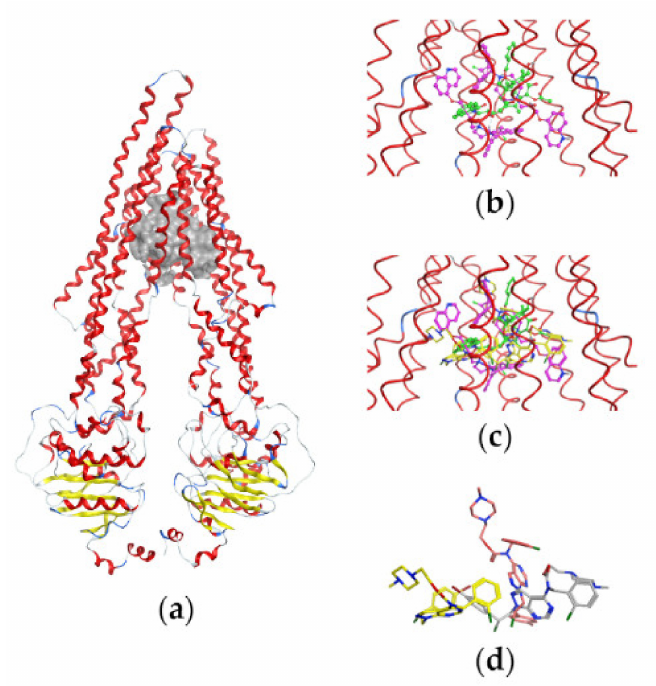
Figure 6. Binding of pro-Si221 in the P-gp cavity. ( a ) A front view of the P-gp structure used in docking studies with the bound substrate PTX (in green) and two molecules of the inhibitor Zosuquidar (in magenta); the protein backbone is shown as a ribbon and is colored according to the secondary structure—loop (in grey), helix (in red), and turn (in blue). ( b ) A closer view of the transmembrane-binding cavity of P-gp with bound PTX and two molecules of Zosuquidar (shown as balls and sticks). ( c ) A closer view of the transmembrane-binding cavity of P-gp with bound PTX, Zosuquidar, and three conformations of pro-Si221 (yellow sticks) corresponding to three different binding poses among the 10 best generated during docking. ( d ) The three different poses of pro-Si221 (shown as yellow, orange, and light gray sticks) positioned equally to those on ( c ). For a better view, the protein backbone is shown as a line ribbon in ( b , c